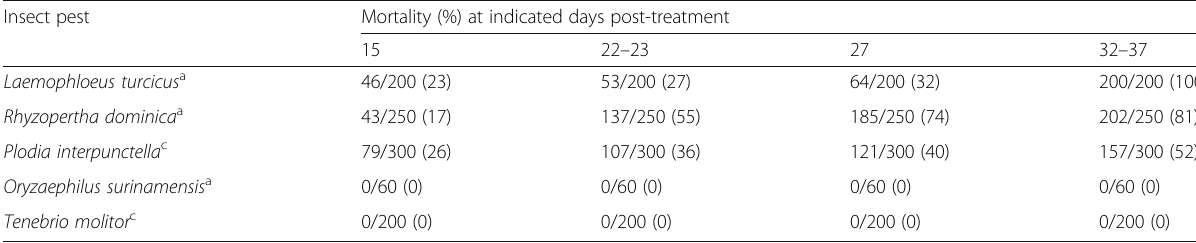
Table 3 Pathogenicity of a single dose of Mattesia sp. isolated from Laemophloeus turcicus adults versus different insects at indicated days post-treatment Insect pest